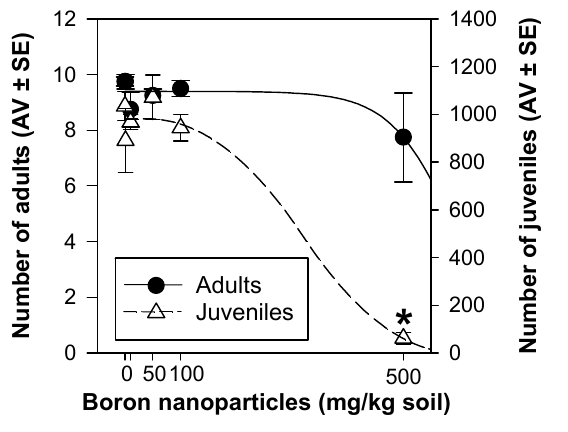
Boron nanoparticles (mg/kg soil)